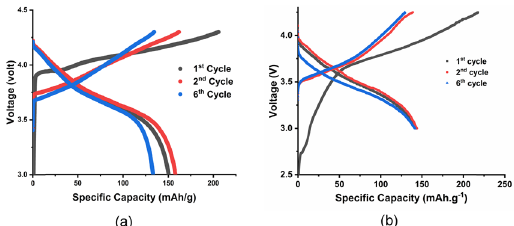
Figure 5: Charge – discharge pro fi le of ( a ) NCA/LiPF 6 /Cu AFLIB and ( b ) full cell NCA/LiPF 6 /graphite